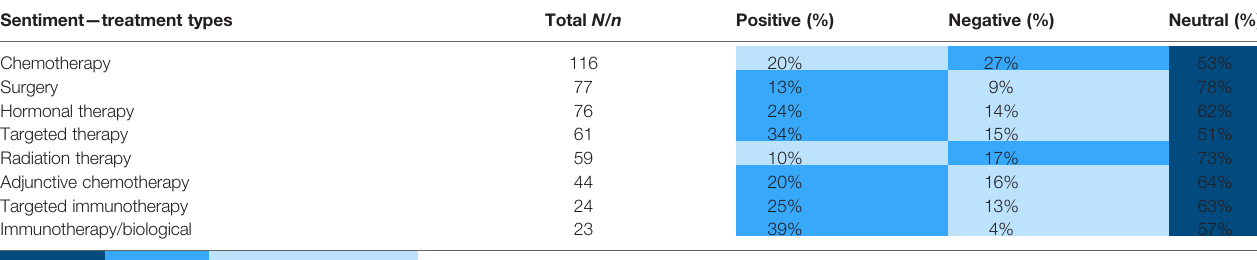
TABLE 4 | Sentiment regarding treatment types.